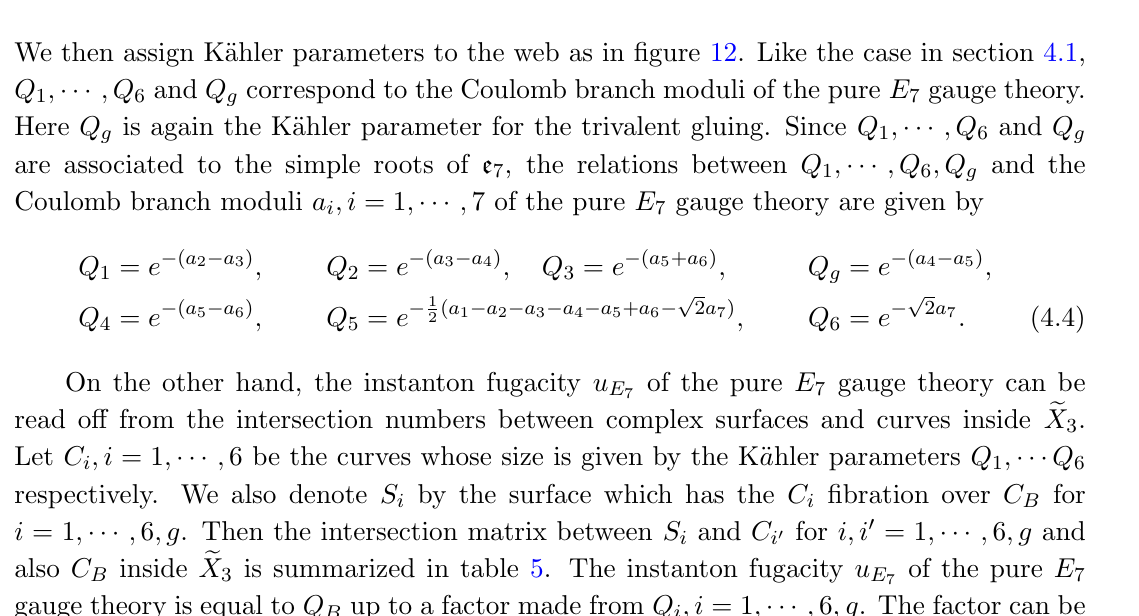
Figure 12 . The assignment of the K(cid:127)ahler parameters to the web in (cid:12)gure 11. We write the three webs separately for